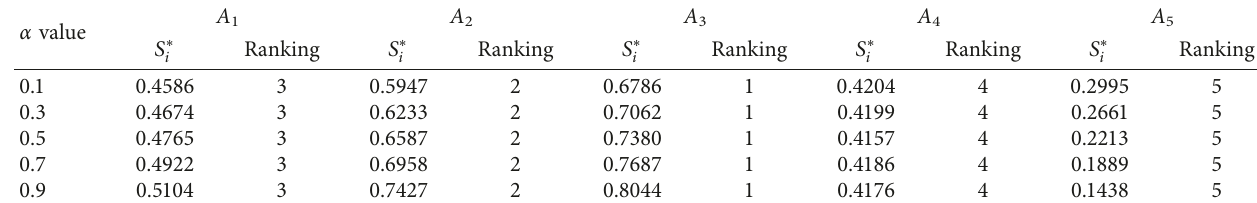
Table 7: Ranking results of different α values.